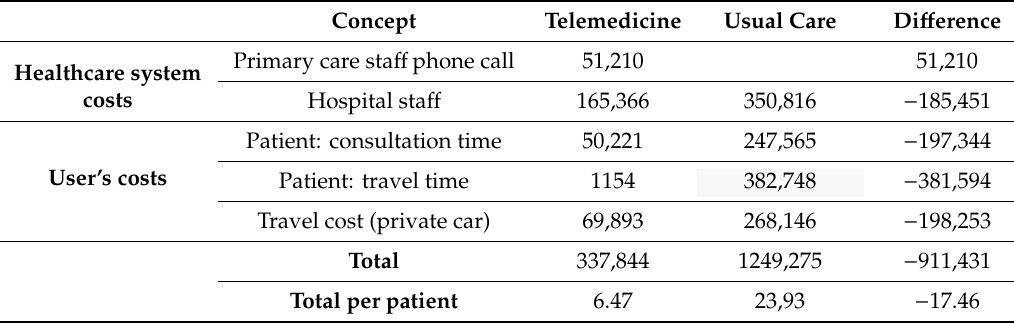
Table 5. Sensitivity analysis: 20% increase in costs. Main results ( €